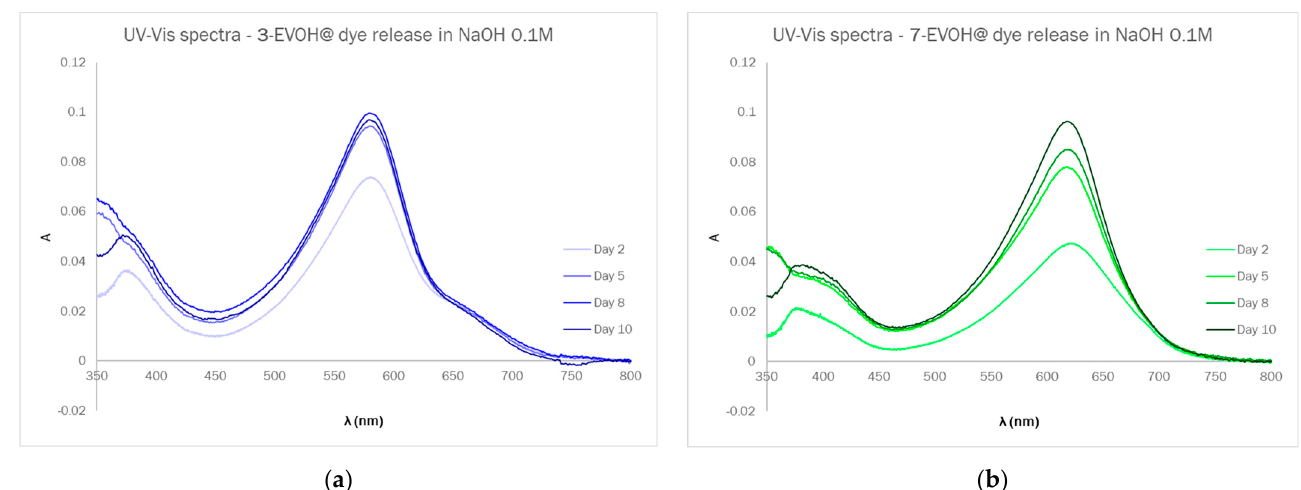
Figure 7. UV–Vis spectra of solutions registered during release experiments in the case of 3-EVOH@ ( a ) and 7-EVOH@ ( b ).